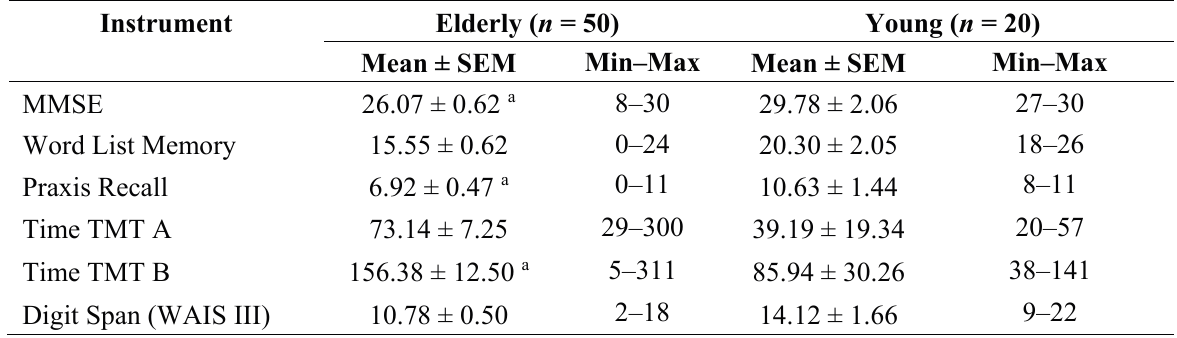
Table 2. Cognitive performance under the different applied instruments in all studied groups.